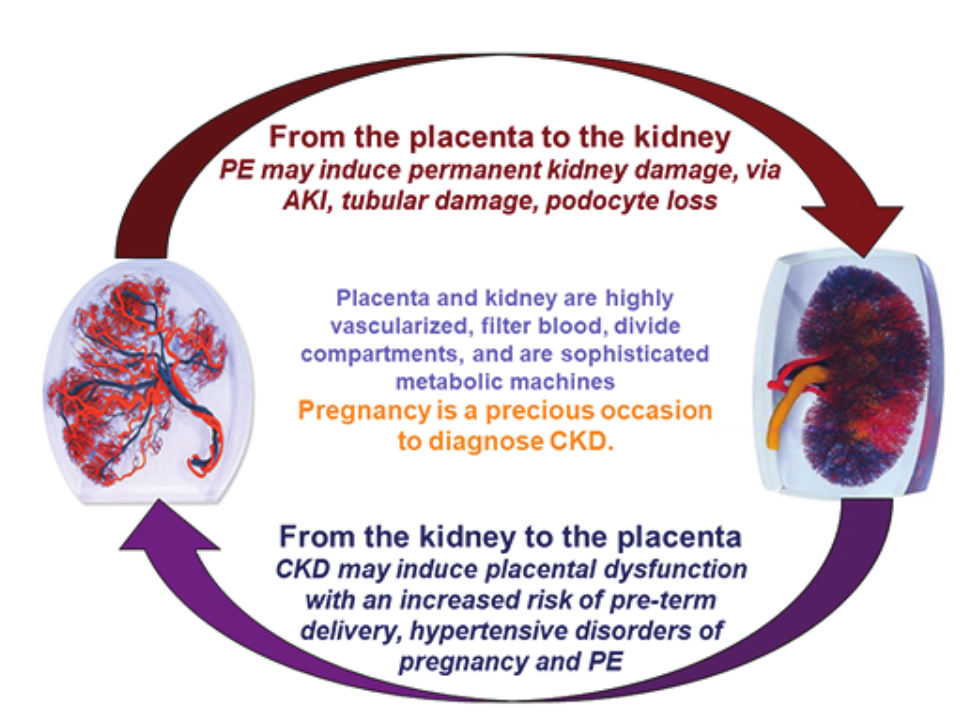
Figure 2. Pregnancy and kidney function: complex interactions between kidney and placenta. PE: preeclampsia; AKI: acute kidney injury; CKD: chronic kidney disease.